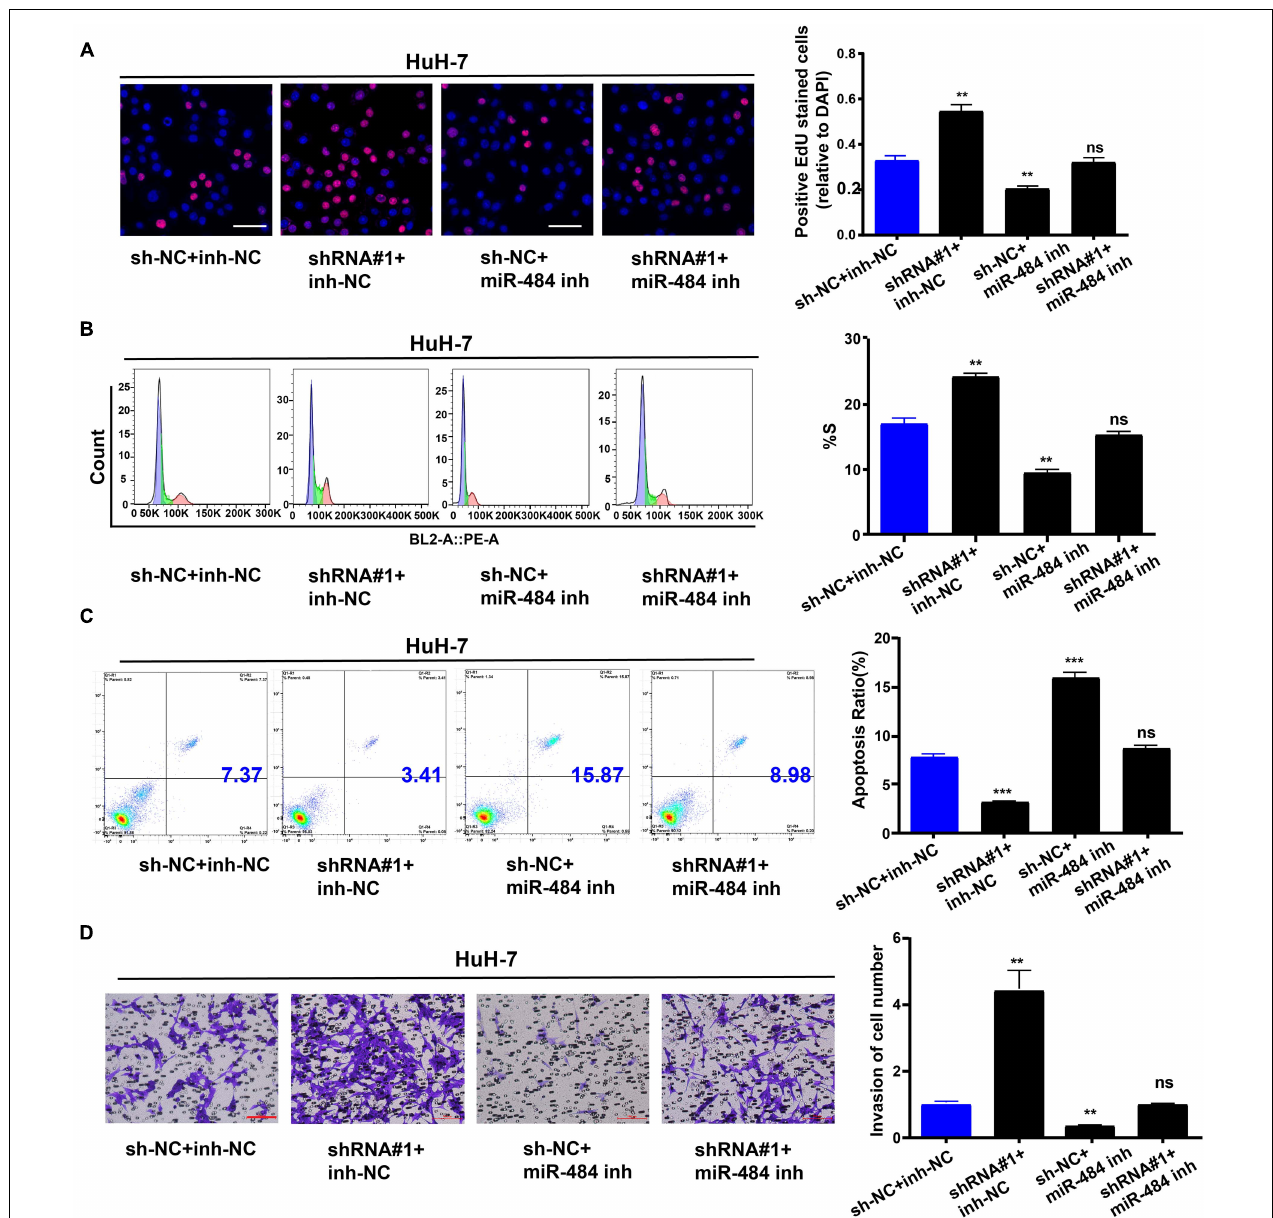
FIGURE 7 | TMEM220-AS1/miR-484 axis regulates behaviors of HCC cells. (A) EdU assays were used to determine the cell proliferation ability of HuH-7 cells. (B) Cell cycle (bar = 50 µ m). (C) Cell apoptosis. (D) Cell invasion (bar = 100 µ m). Data were presented as represent the mean ± SD of 3 independent experiments; ** P < 0.01, *** P < 0.001, ns, no